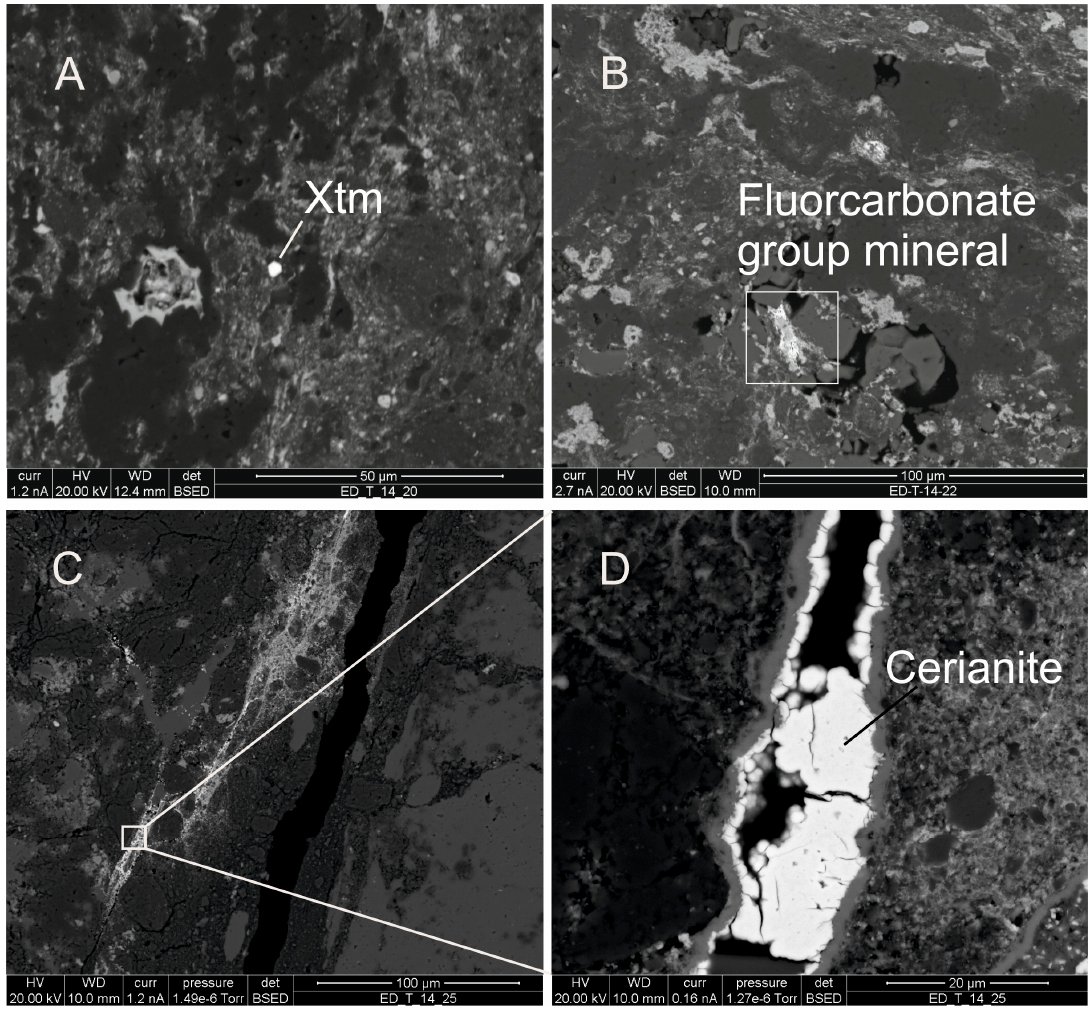
Figure 3. ( A ) Low-Ca bauxite—xenotime (Xtm) in the matrix; ( B ) High-Ca bauxite—interstitial fluorcarbonate; ( C ) Clay-rich bauxite—framboidal cerianite infill along fractures; ( D ) Clay-rich bauxite—framboidal cerianite in fractures.